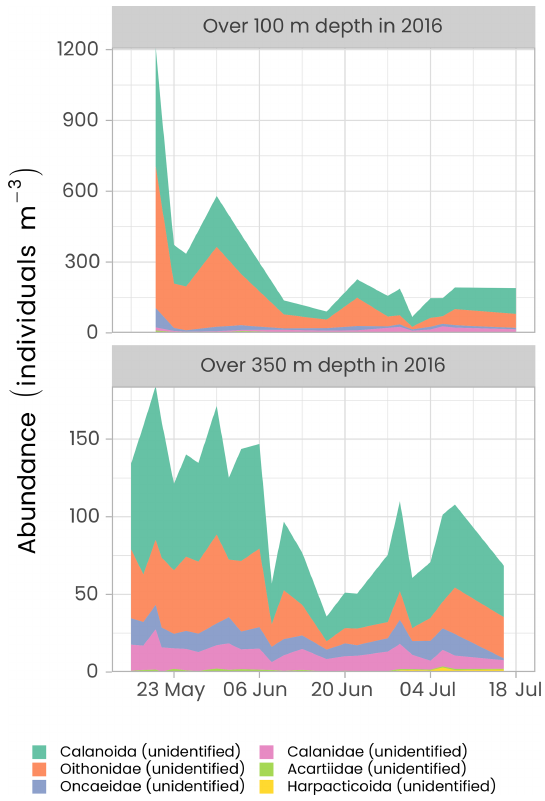
Figure 14. Time series of the abundance of the copepods (individ- uals per m − 3 ) measured over the first 100 and 350m of the water column in 2016 using the ZooScan. For visualization, only the six most abundant groups are presented in decreasing order of impor- tance. Note the different y axes in both